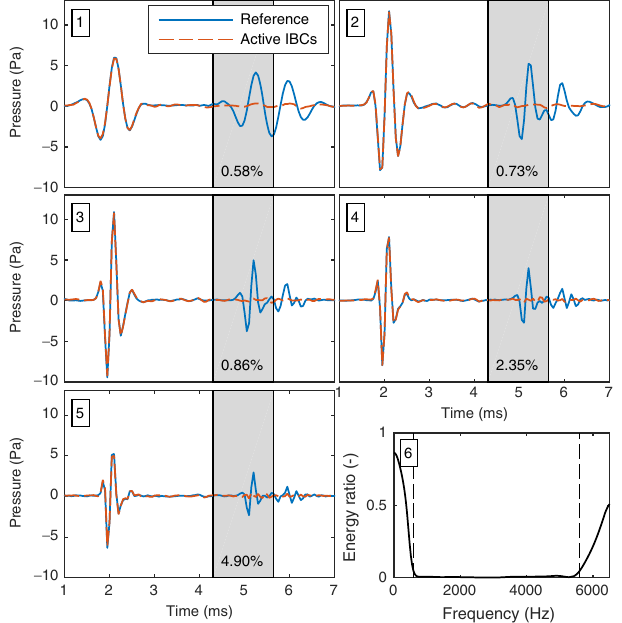
FIG. 6. Panels 1 – 5 show pressure recordings at x rec 1 for emitted Ricker wavelets with center frequencies from 1 to 5 kHz. Results with an active IBC source (red dashed trace) are compared to the reference with an inactive IBC source (blue solid trace). The first reflections from the right tube boundary are contained in the grey boxes. Numbers represent the energy (sum of the squared pressure values) in the window relative to the reference trace. Panel 6 depicts the energy in the window relative to the reference as a function of frequency, summed over all five